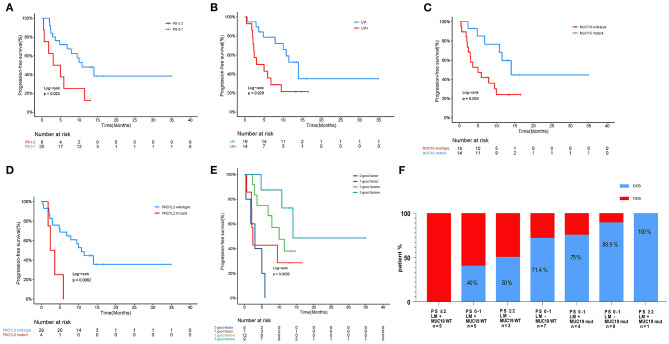
Association of clinicopathological characteristics and gene mutation with anti-PD-1 inhibitor responses in our cohort. (A) Kaplan-Meier curves of PFS comparing patients with low performance (PS 0–1) and high performance (PS ≥ 2). (B) Kaplan-Meier curves of PFS comparing patients with or without intra-pulmonary metastasis. LM+, intra-pulmonary metastasis in the presence or absence of other extra-pulmonary metastases; LM-, only extra-pulmonary metastasis. (C) Kaplan-Meier curves of PFS comparing patients with mutant and wild-type MUC19. (D) Kaplan-Meier curves of PFS comparing patients with mutant and wild-type PKD1L2. (E) Effect of MUC19 mutation status combined with performance and intra-pulmonary metastasis status on PFS in our cohort. (F) Histograms depicting proportions of patients who experienced DCB or NDB in different groups, defined by performance status (PS 0–1 or PS ≥ 2), intra-pulmonary metastasis (yes or no), and MUC19 mutation status (mutant or wild-type), as indicated.